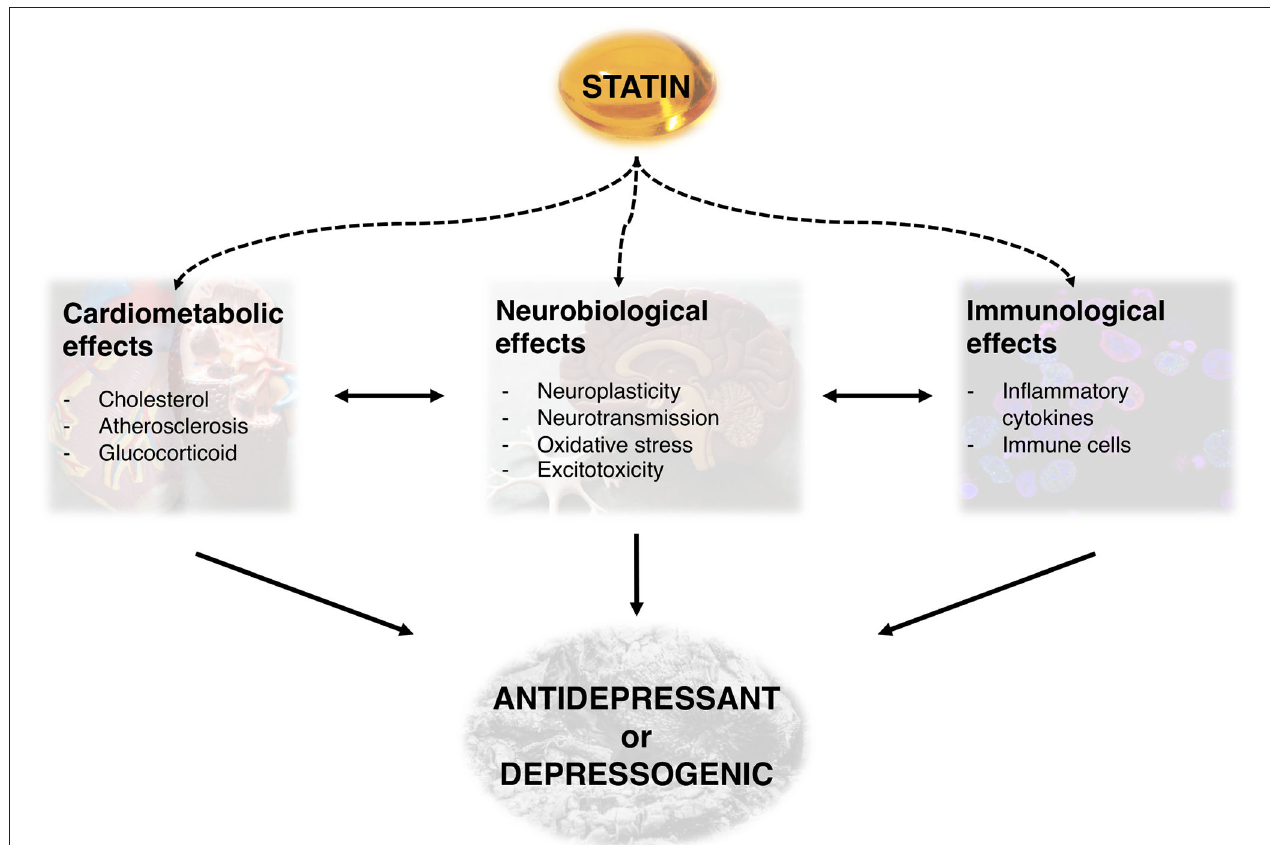
FIGURE 1 | Overview of potential mechanisms underlying the antidepressant or depressogenic effects of